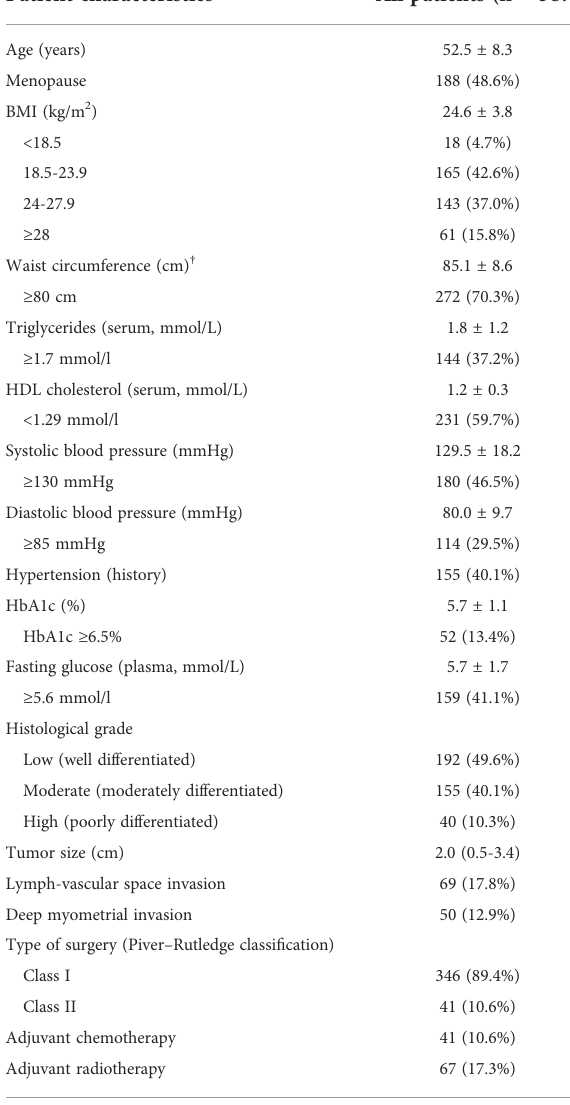
TABLE 1 Patient characteristics at